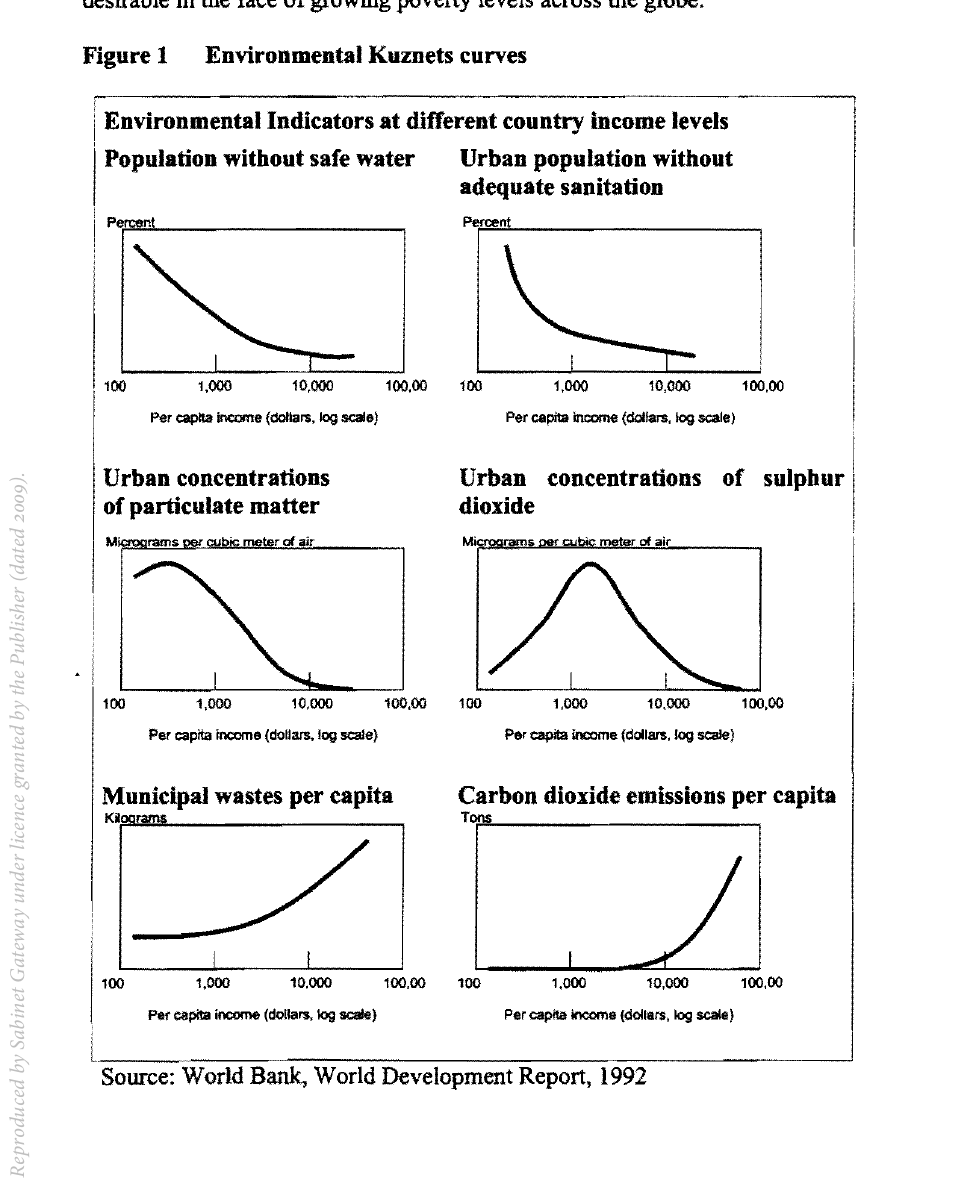
Environmental Kuznets